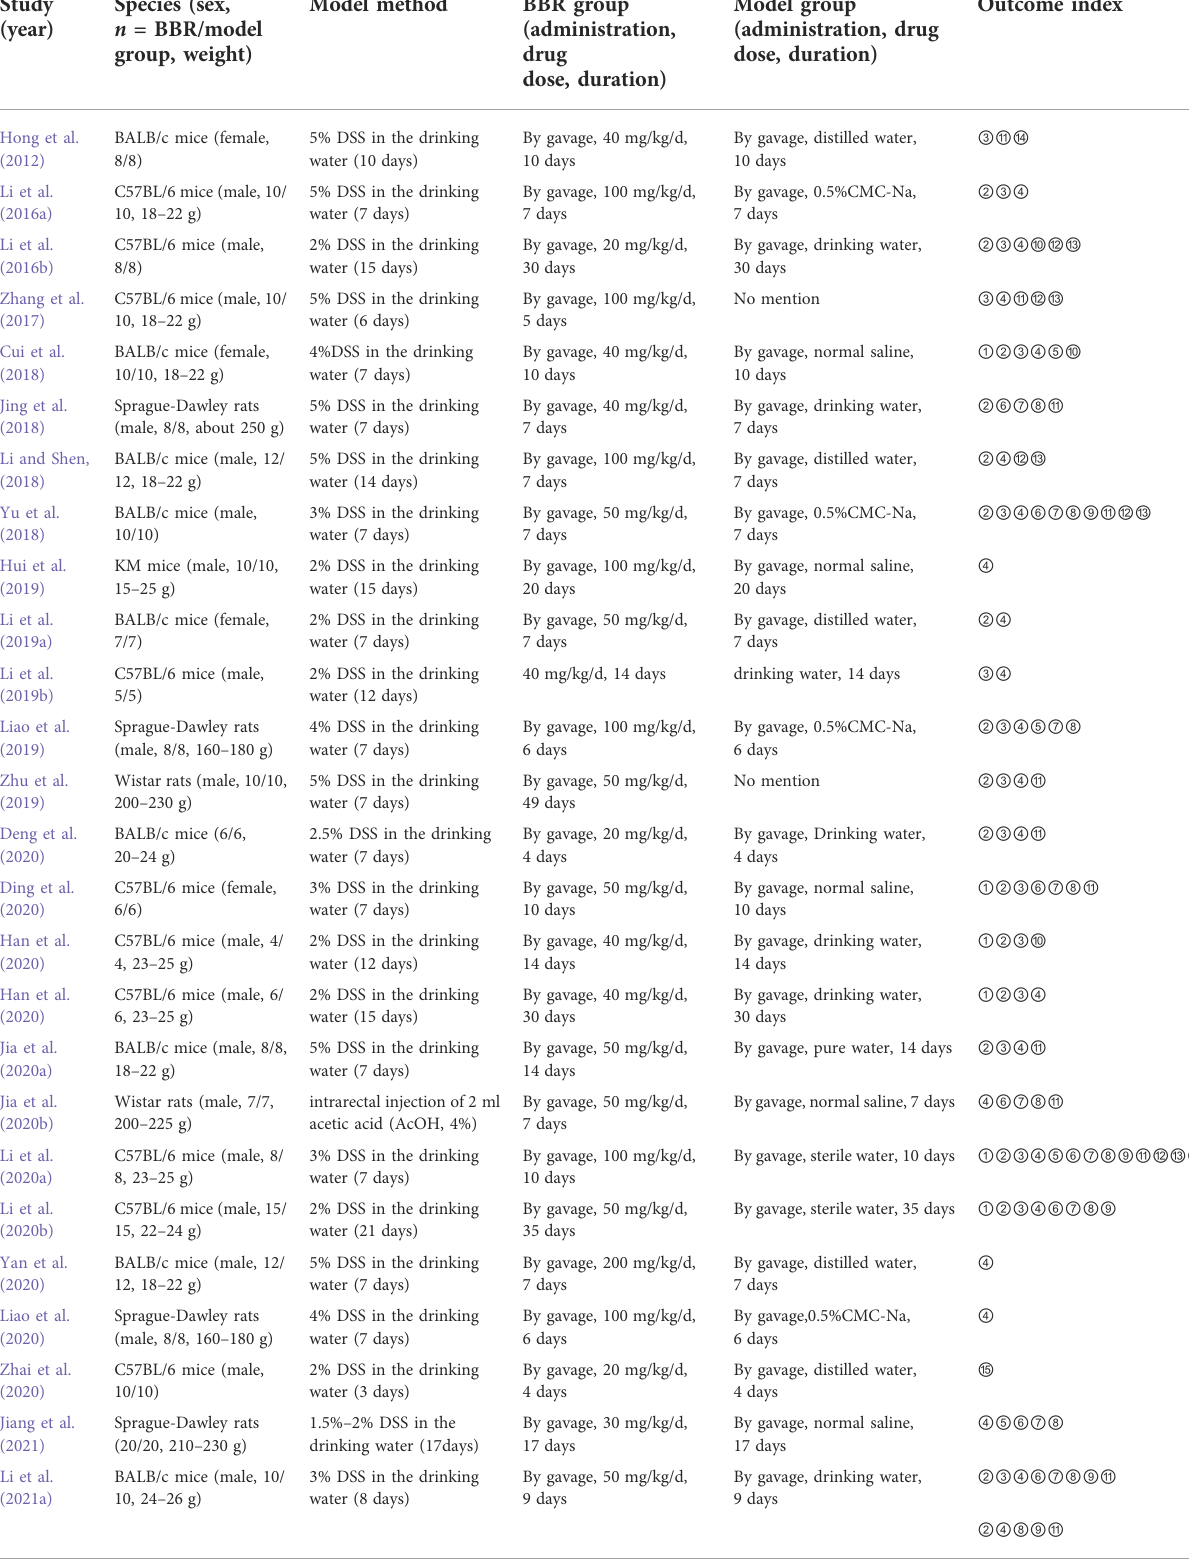
TABLE 2 Basic characteristics of the included